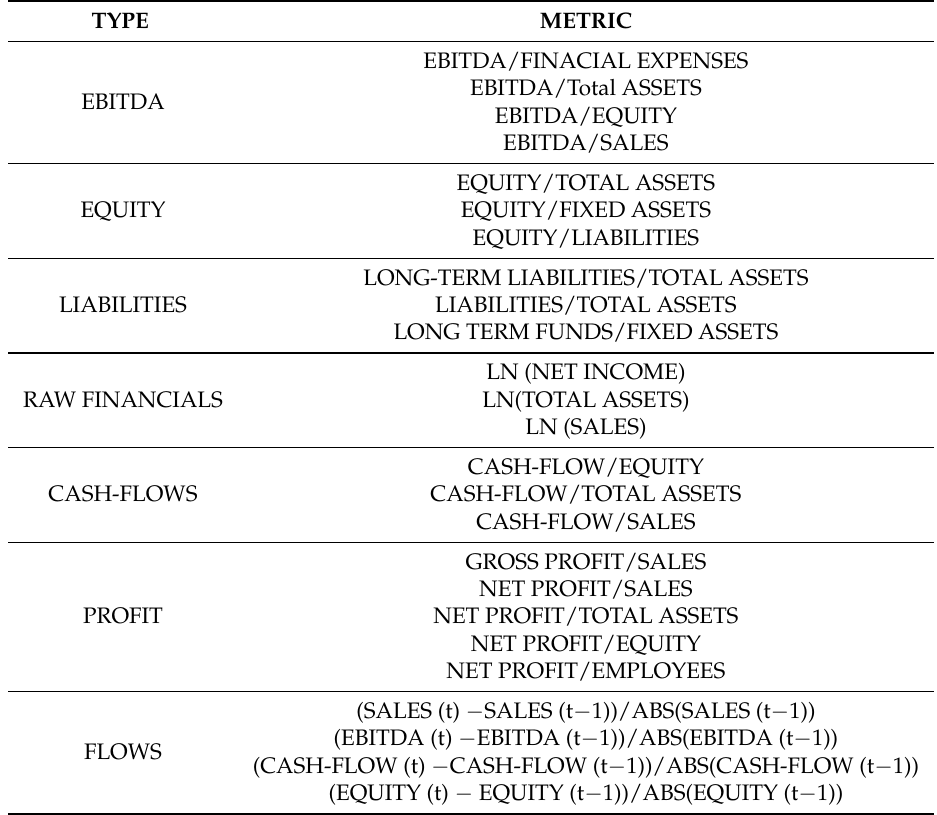
Table 4. Example of variables used in the models, where ’EBITDA’ denotes Earnings Before Interest, Taxes, Depreciation and Amortization; ’ABS’ denotes Absolute Value function; ’LN’ denotes Natural